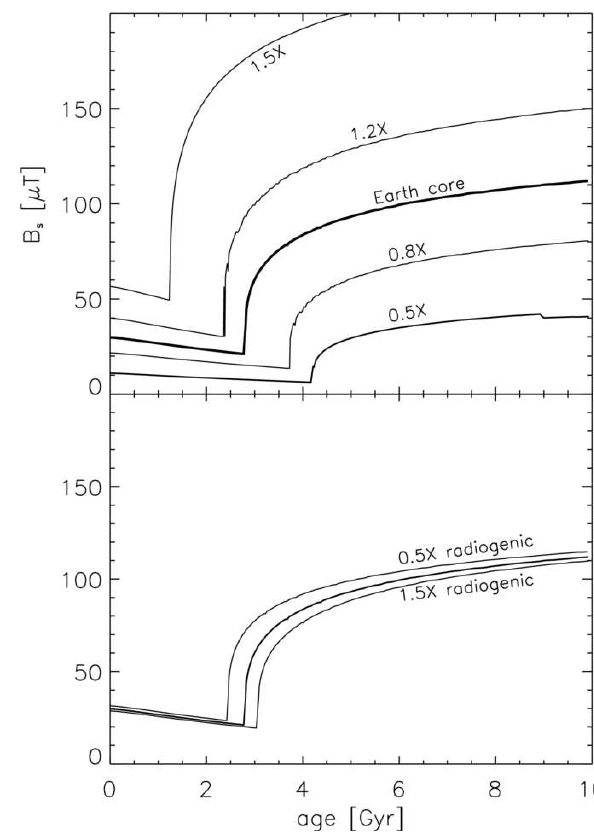
Figure 5. Evolution of the average surface PMF of Earth-like planets with plate tectonics and T = 288 K. Dynamos are assumed dipolar. s Top: planets with core masses between 0.5 and 1.5 that of Earth. Bottom: planets with an Earth-size core but initial radiogenic ele- ment abundances that are 0.5 or 1.5 the terrestrial case (heavy solid line). (Figure from GA10, with permission of the